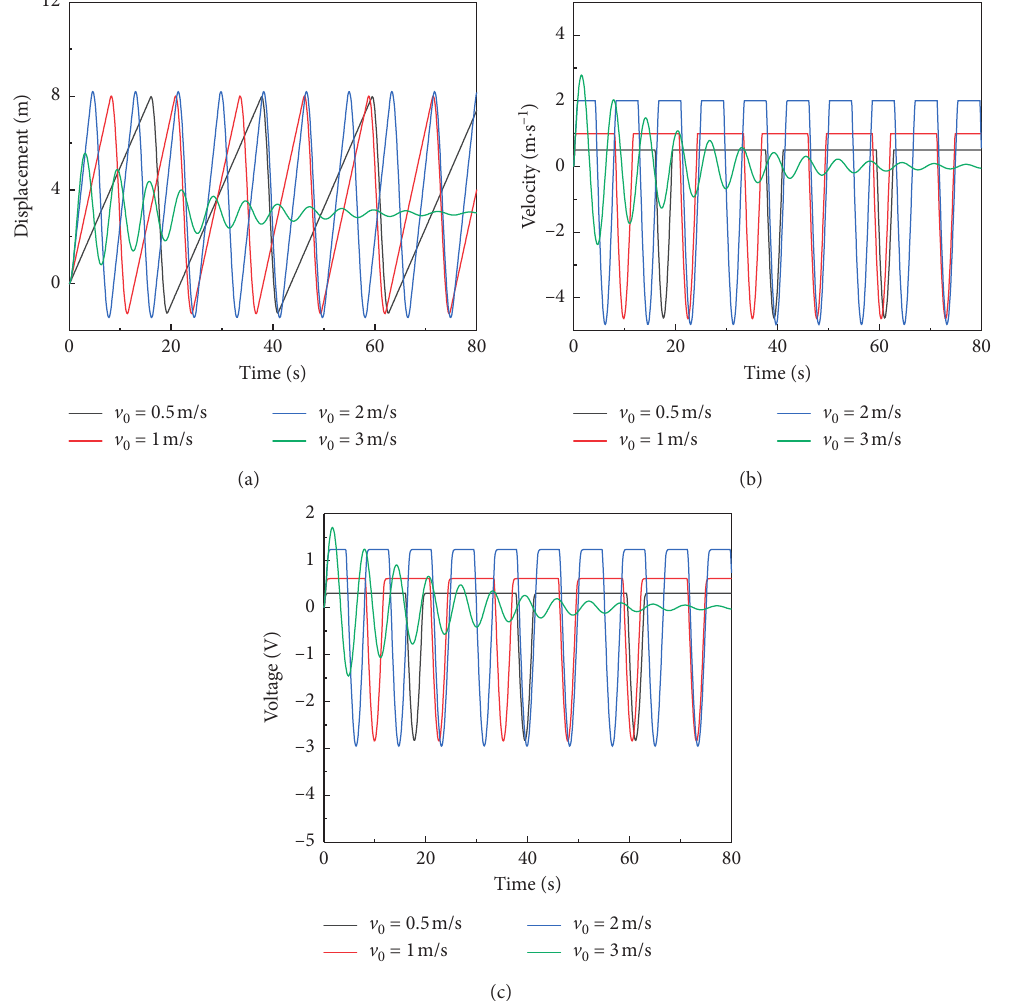
Figure 6: The displacement (a), velocity (b), and output voltage (c) of the friction system with different velocities in the friction law I.